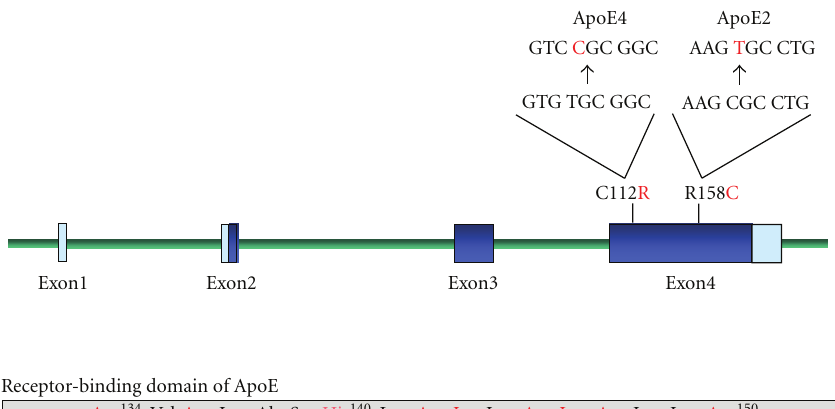
Figure 1: Structure of the human APOE gene. The APOE gene has 4 exons, comprising 44, 66, 193, and 860 nucleotides, with over 80% of the protein coded for by exon 4. Exon 1 contains 5 (cid:3) untranslated sequence, while the translated sequence in exon 2 codes for most of the 18 residue signal peptide. As indicated, exon 4 contains the two common disease-associated SNPs: a T → C point mutation produces ApoE4 (Cys112Arg), while C → T mutation gives ApoE2 (Arg158Cys). The wild-type sequence is ApoE3 (Cys112, Arg158). Also shown in the lower part of the figure is the positively charged arginine- and lysine-rich α -helical segment (residues 134–150) which recognizes the LDL